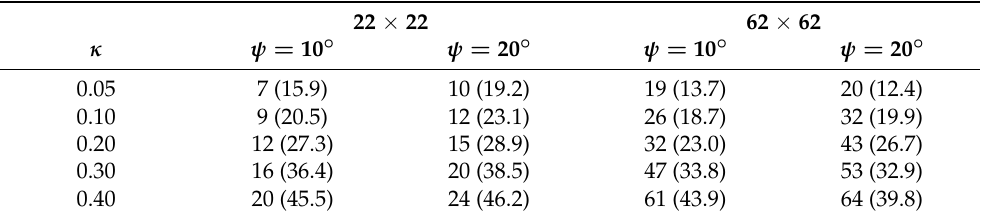
Table 2. Number of u slave cells generated and their percentage (in parenthesis) over total u cut cells for the inclined channel flow case as function of κ , ψ and grid size.